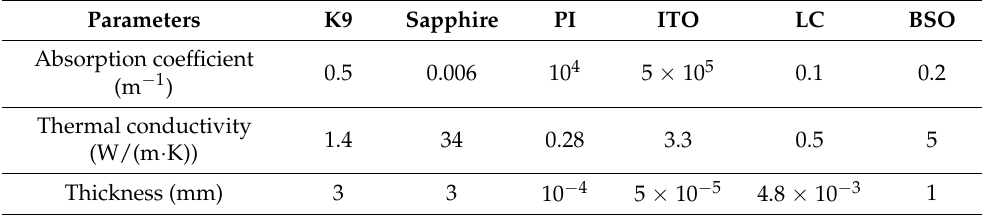
Table 1. Some material parameters related to thermal